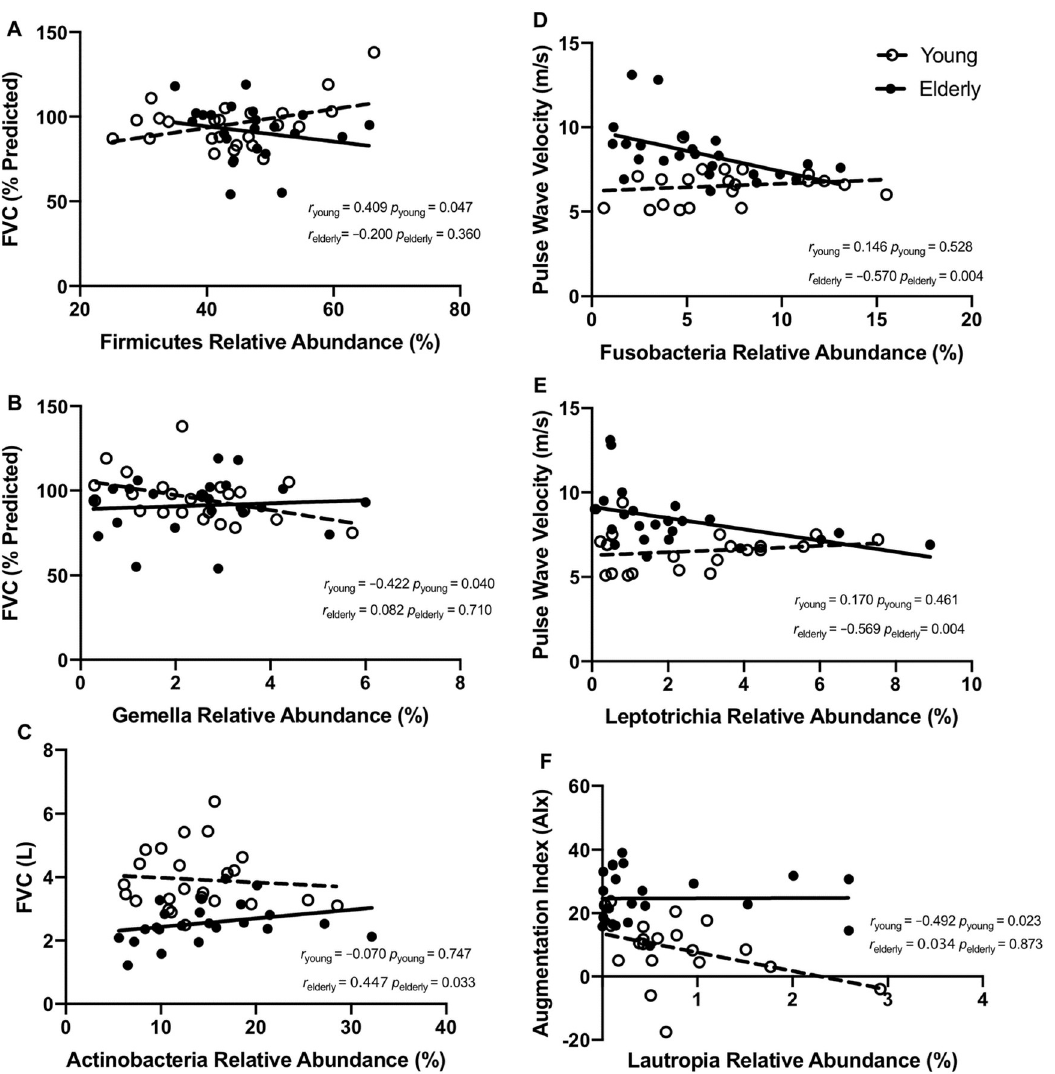
Fig 4. Physiological correlates of the microbiome at phylum and genus level. Sub-group correlations between specific lung microbiota, lung function and arterial stiffness parameters are indicated. Lung function—microbiome correlations were observed in the young but not the elderly group, between FVC (%Predicted) and relative abundance of (A) phylum Firmicutes and (B) genus Gemella . Correlations observed in the elderly but not the young group included (C) FVC and relative abundance of the genus Actinobacteria . Arterial stiffness and lung microbiome correlations were observed in the elderly group, between pulse wave velocity and relative abundance of (D) phylum Fusobacteria and (E) genus Leptotrichia while correlation between (F) augmentation index and the relative abundance of Lautropia was observed in young subjects. Young and elderly measures are indicated by unfilled and filled circles respectively. The line of best fit is indicated with a broken line for the young population and with a continuous line for the elderly. Correlation coefficients and associated p values are indicated for young sub-group ( r young ) and elderly sub-groups ( r elderly